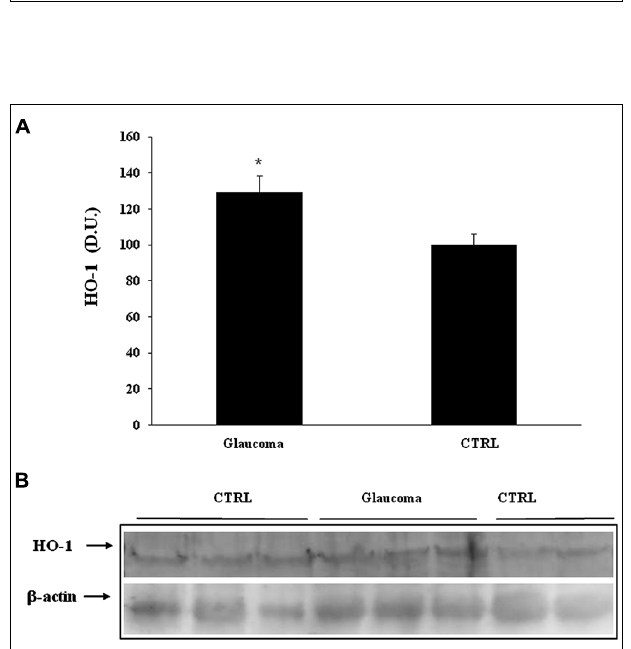
FIGURE 3 | (A) HO-1 protein levels in plasma of glaucoma and control subjects. Samples from control and patients with glaucoma were assayed for HO-1 expression byWestern blot. A representative immunoblot is shown. β -actin has been used as loading control. (B) Densitometric evaluation: the bar graph shows the values are expressed as mean standard error of mean of 3 independent analyses. * P < 0.05 vs. control. D.U., densitometric units; CTRL, control.